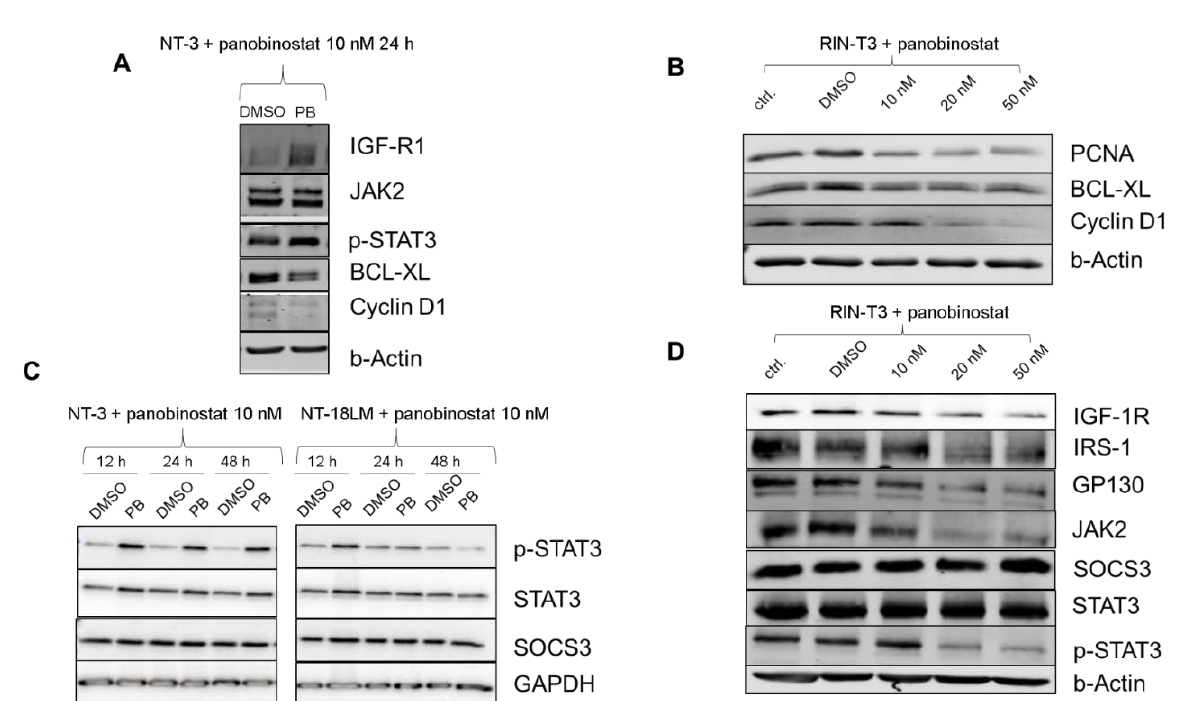
Figure 5. Effector targets of panobinostat and interference with the JAK2/STAT3 signaling. ( A , C ): Protein lysates of panobinostat (10 nM) treated NT-3 cells after 12 h, 24 h and 48 h are presented. DMSO served as control. Downstream effectors BCL-XL and Cyclin D1 were reduced upon PB therapy. Panobinostat increased the expression of IGF-R1 after 24 h and p-STAT3 at all time points. SOCS3 expression remained unchanged. ( B , D ): RIN-T3 cells were treated with PB and analyzed for changes in JAK/STAT signaling. ( B ): BCL-XL, Cyclin D1 and PCNA were downregulated after 48 h of PB treatment ( B ). Expression level of endogenous SOCS3 and STAT3 was not affected by PB. Dose-dependent decrease in protein expression was observed for IGF-1R, GP130, JAK2 and p-STAT3 ( D ).